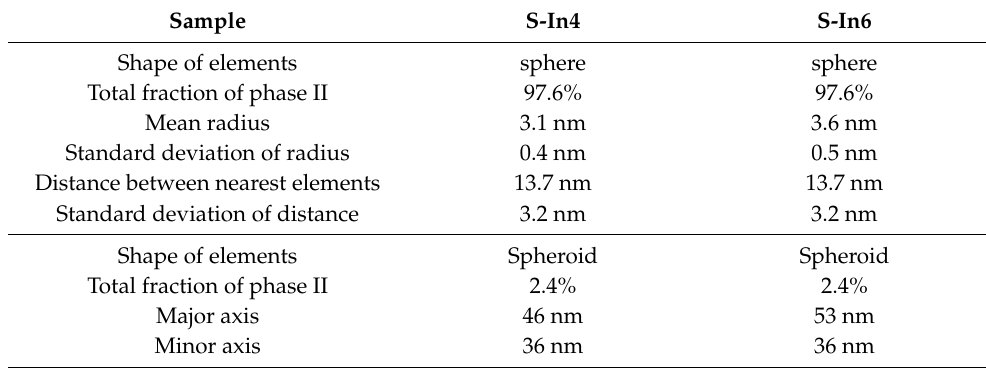
Table 1. Parameters of the model, corresponding to the fit in Figure